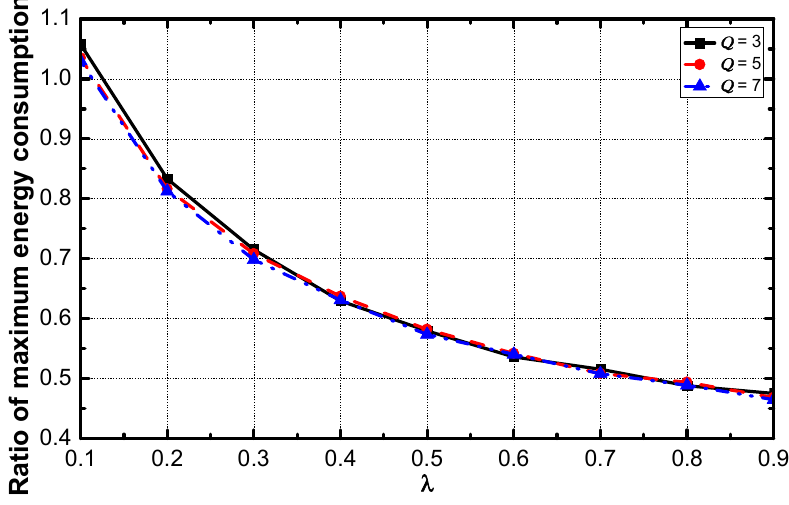
Figure 14. The average ratio of maximum energy consumption vs. λ